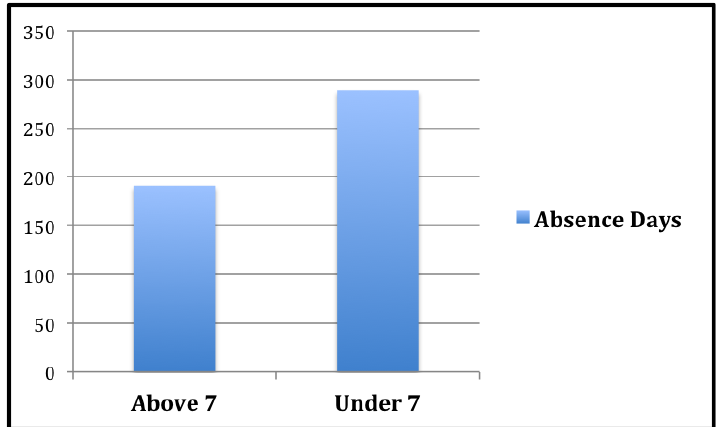
Figure 3. Student